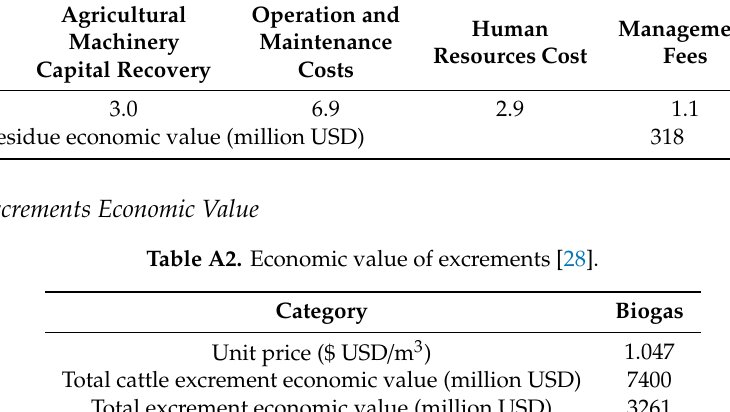
Table A1. Cost table for crop residue collection process [67].